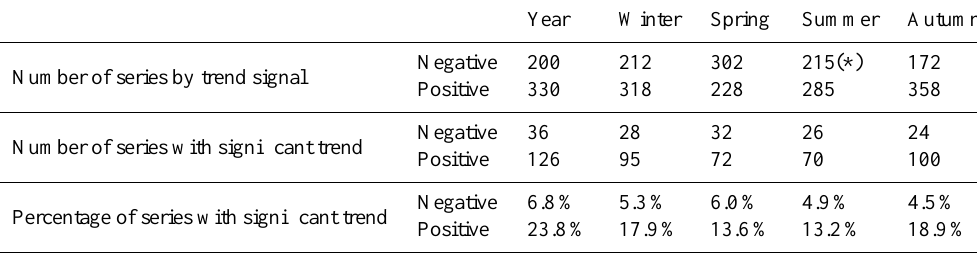
Table 1. Trend analyses of CI. Number of stations by trend signal and level of significance ( p < 0 .